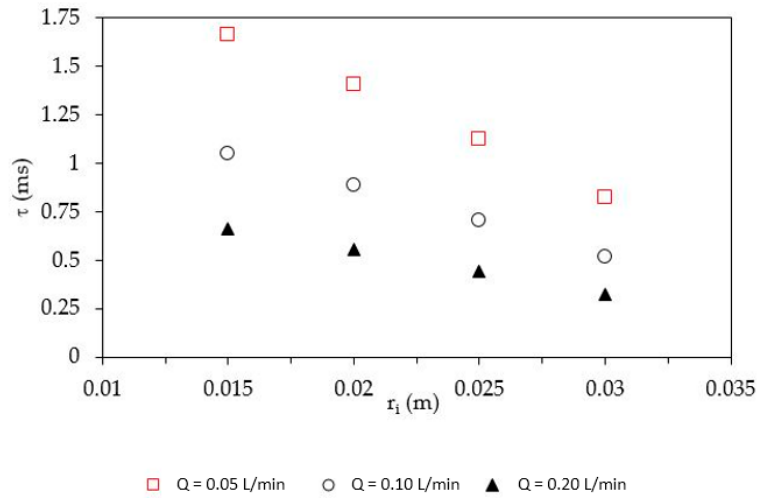
Figure 5. r i influence on residence time.